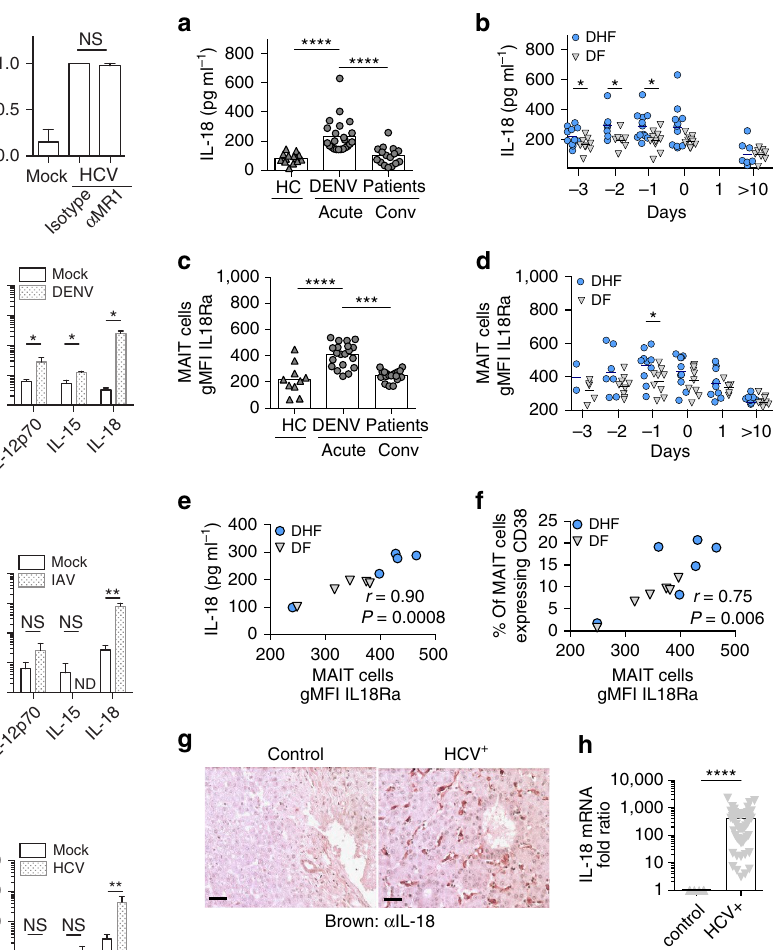
Figure 5 | Virally triggered IL-18 correlates with MAIT cell